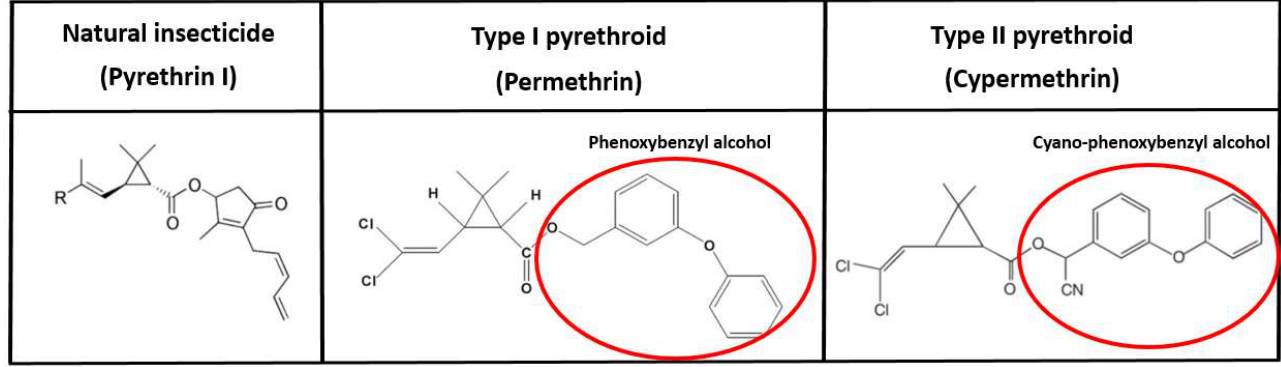
Figure 2. Chemical structure of pyrethroid insecticides (From left to right: pyrethrin I, permethrin, cypermethrin). The introduction of phenoxybenzyl alcohol moiety into the chemical structure of natural pyrethrins increases the stability of the Type I pyrethroids. All Type II pyrethroids have a cyanide group.